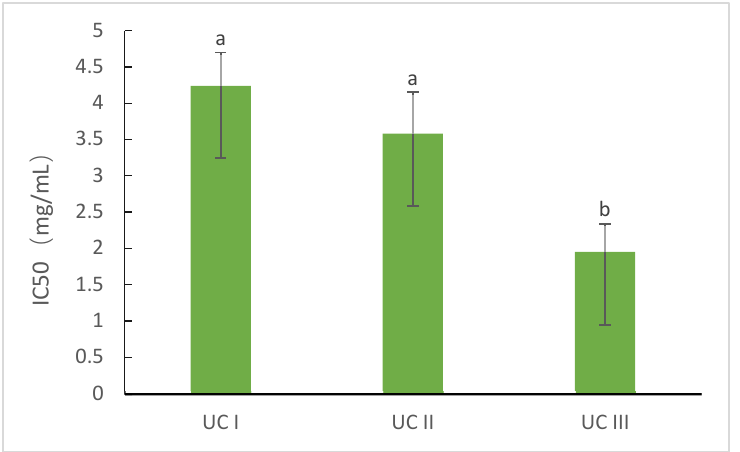
Figure 2. Dipeptidyl peptidase IV (DPP-IV) inhibitory activity of each fraction. Different letters indicate significant differences ( p < 0.05).